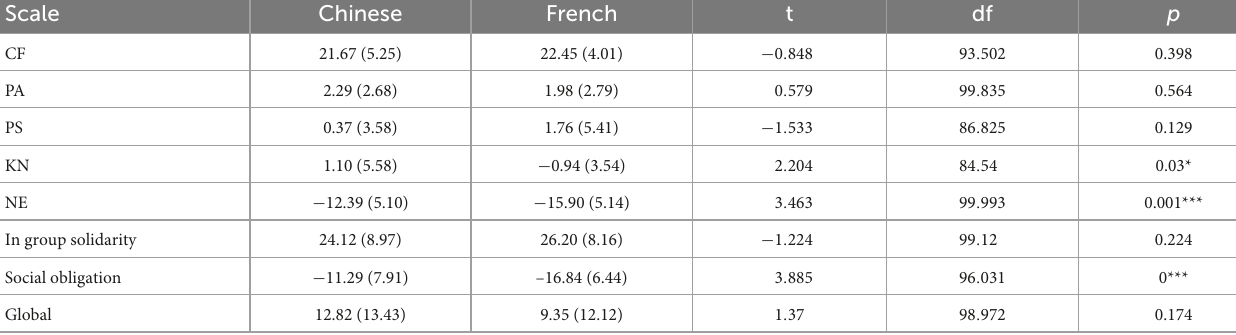
TABLE 2 Results of individualism-collectivism scale IND-COL scales and subscales (Hui and Yee, 1994). Scale